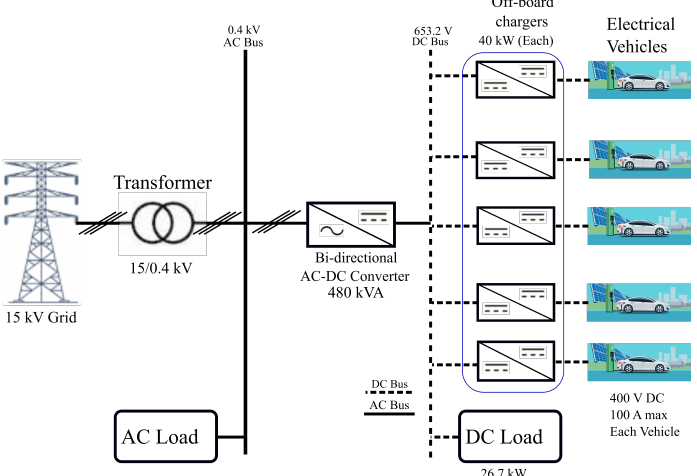
Figure 11. Bi-directional flow of power: G2V and V2G